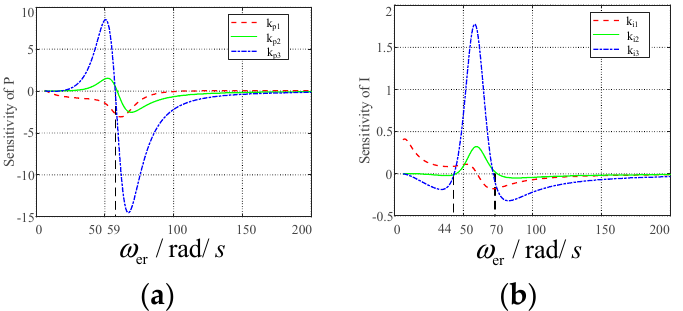
Figure 9. Electrical damping sensitivity of system under different proportional and integral param- eters: ( a ) proportional coefficients; ( b ) integral coefficients. ters: ( a ) proportional coefficients; ( b ) integral